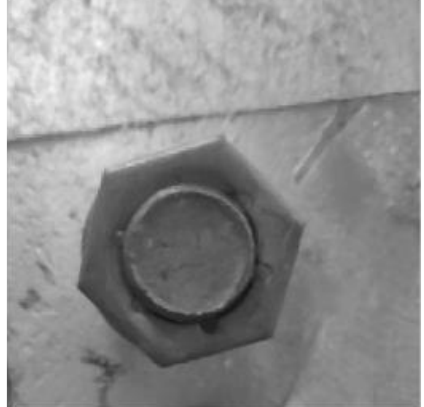
Figure 7. Denoising